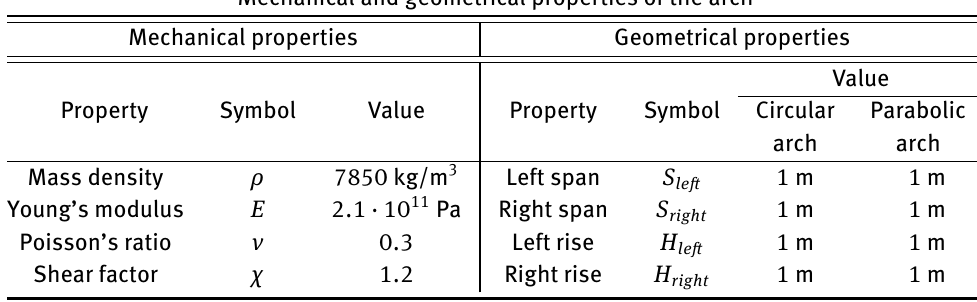
Table 2: Mechanical and geometrical parameters used in the free vibrations analysis. Mechanical and geometrical properties of the